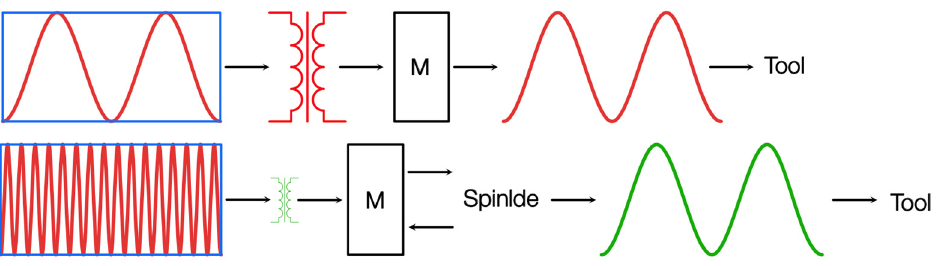
Figure 15. Further minimization of the system dimensions.